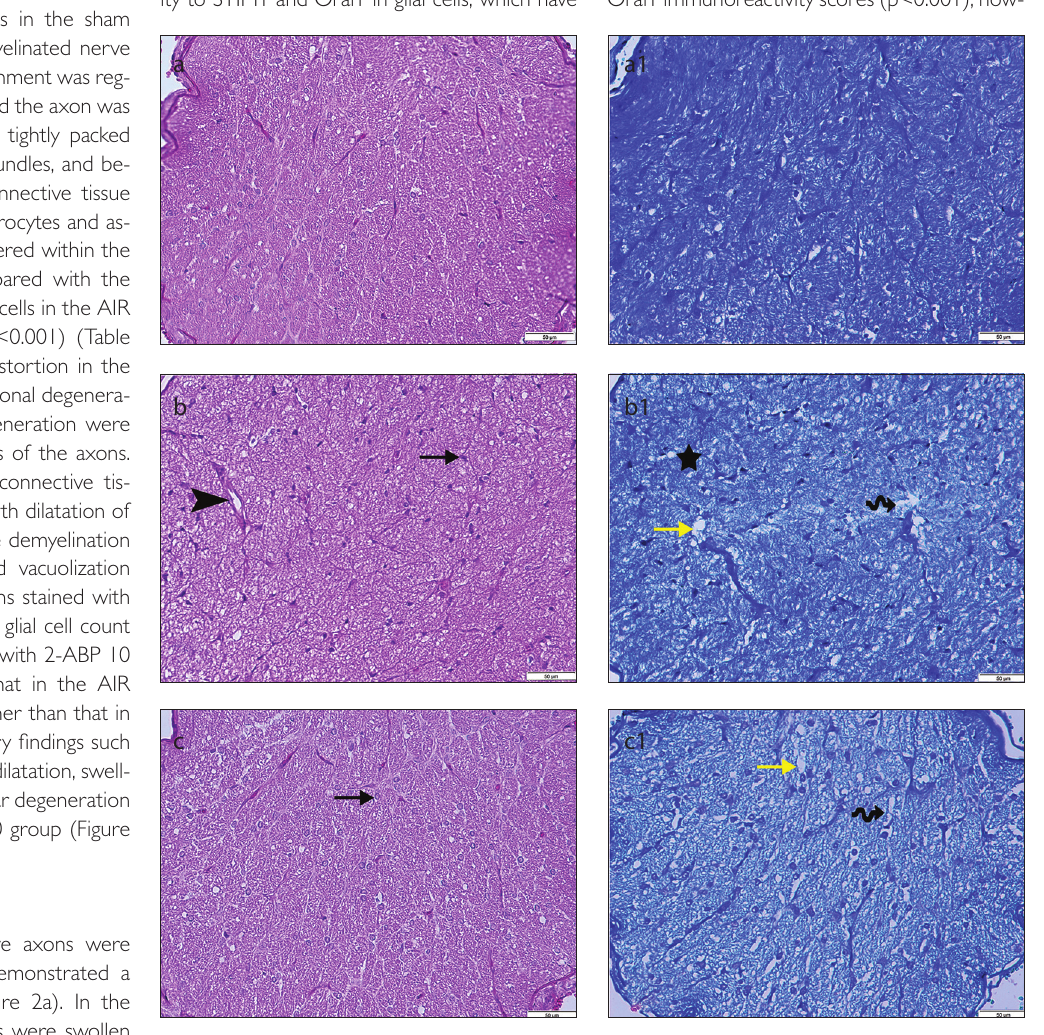
Figure 1. a-c Light photomicrographs of optic nerve tissues stained with Hematoxylin-eosin (a-c) and toluidine blue (a1-c1). Black arrow: glial cell, yellow arrow: vacuolar degeneration, arrow head: dilation of the capillaries, ⋆ : glial cell increase and ↝ : demyelination areas. (a-a1) Sham groups; (b-b1) AIR groups; (c-c1) AIR10 group. Bars: 50 μm. Table 1. Numerical densities and immunoreactivity scores of glial cells in the control and experimen- tal groups Glial cells